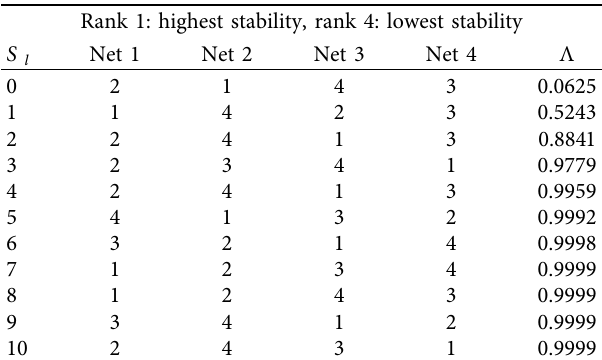
Table 5: Ranking of networks according to stable state level and effect on network activities as a function of sensitivity.